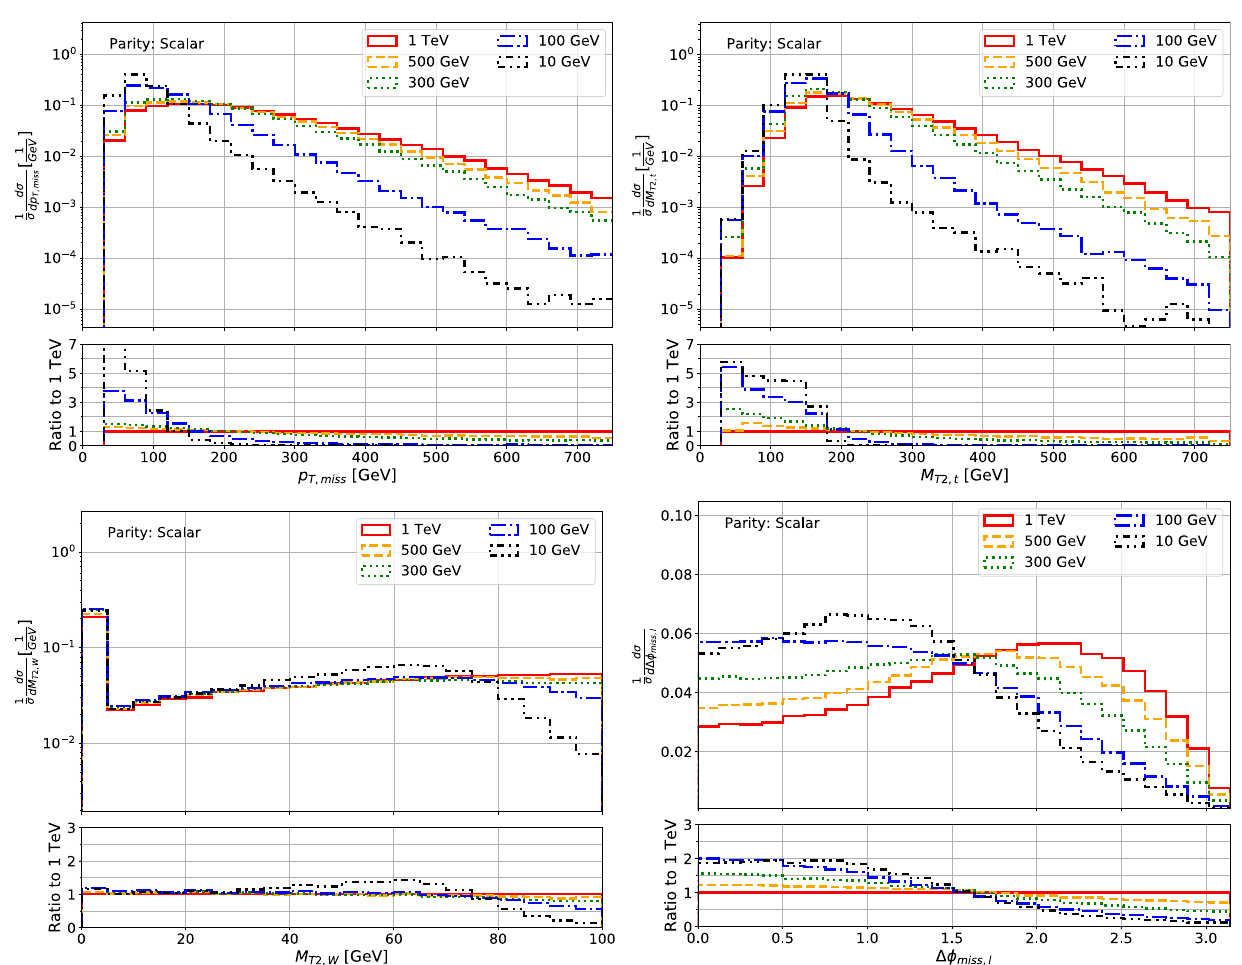
Fig. 5 Comparison of normalised NLO differential distributions for the DM signal with a scalar mediator for different mediator masses. The samples have been generated using a central scale of μ DM Table 2 Comparison of integrated background cross sections between the NWA and full off-shell predictions with their respective scale uncer- tainties at LO and NLO. All values are given for the LHC with a center Process Scale Off-shell NWA Off-shell effects (%) t ¯